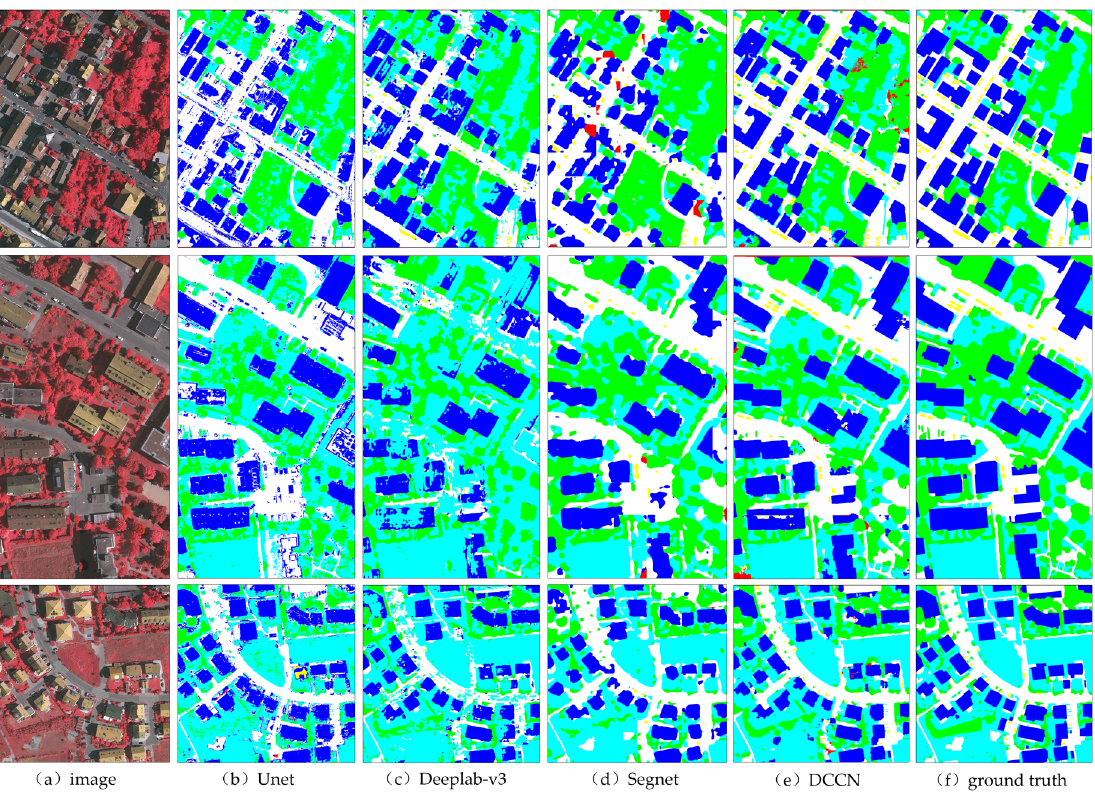
Figure 7. The prediction results of all methods with the Vaihingen dataset. Table 5. Quantitative comparisons of different methods with the Vaihingen dataset.